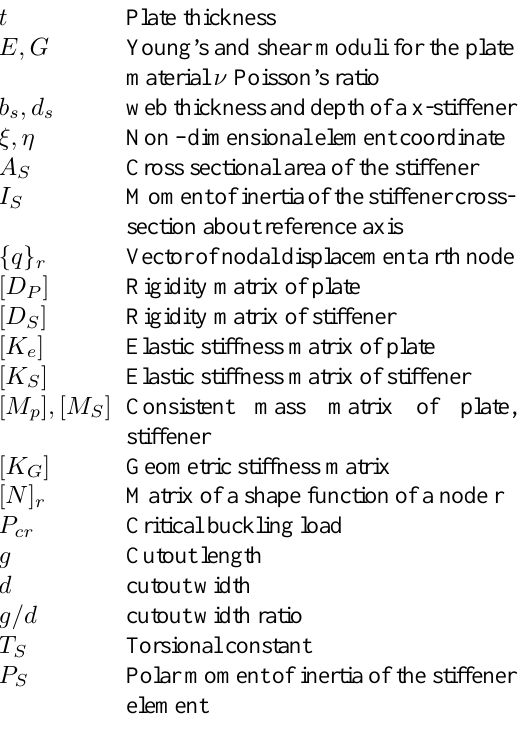
Fig. 18. Effect of boundary conditions on vibration frequency for stiffened square plates with cutouts ( g/d = 2, g/a = 0.4, d/b = 0.4) having one central longitudinal stiffener ( δ = 0.1 and γ =